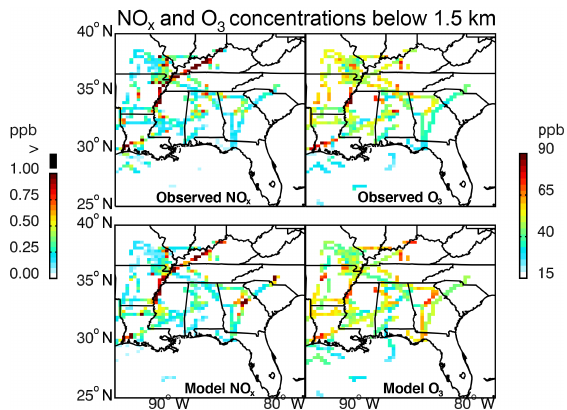
Figure 4. Ozone and NO x concentrations in the boundary layer (0– 1.5km) during SEAC 4 RS (6 August to 23 September 2013). Obser- vations from the aircraft and simulated values are averaged over the 0.25 ◦ × 0.3125 ◦ GEOS-Chem grid. NO x above 1ppb is shown in black. The spatial correlation coefficient is 0.71 for both NO x and O 3 . The normalized mean bias is − 11.5% for NO x and 4.5% for O 3